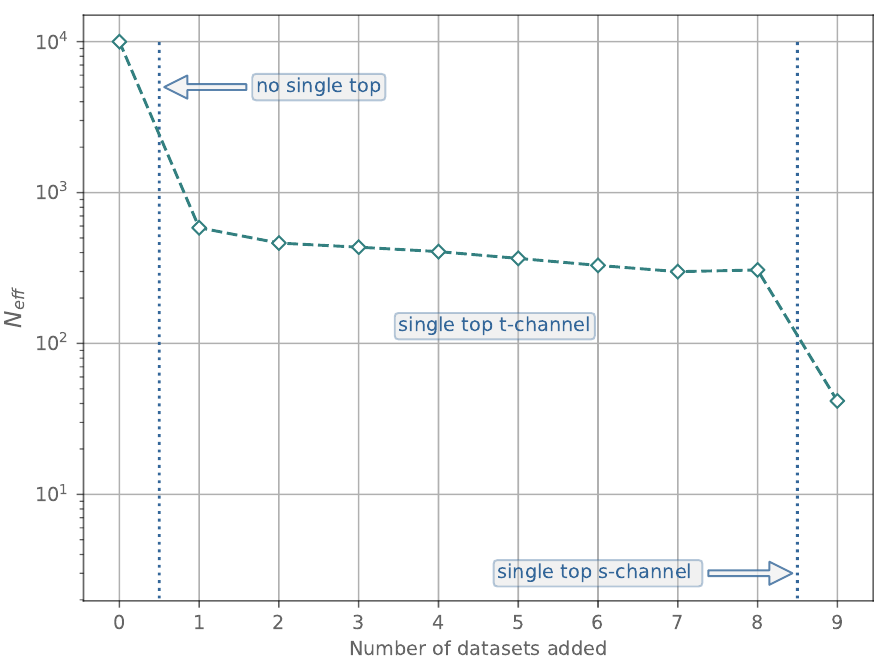
Figure 3.2: The value of the effective number of replicas N does not contain any of the single-top production measurements listed in Table 3.1, and once the various single-top datasets are sequentially added by reweighting. As indicated in the plot, first we add the t -channel datasets and then the s -channel datasets following the order given in Table